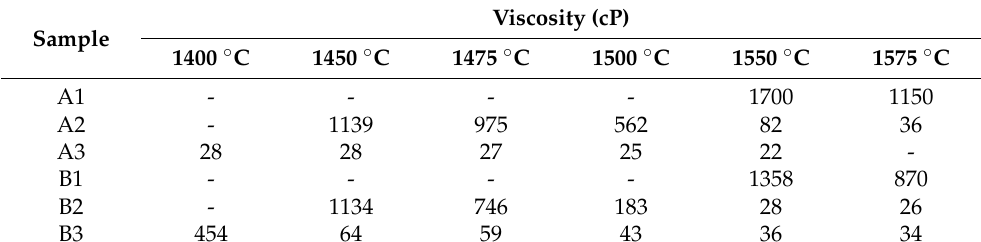
Table 3. Viscosity of each sample at different temperatures.